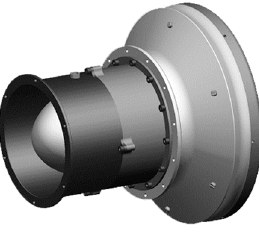
Figure 1. MIX-130 fan.